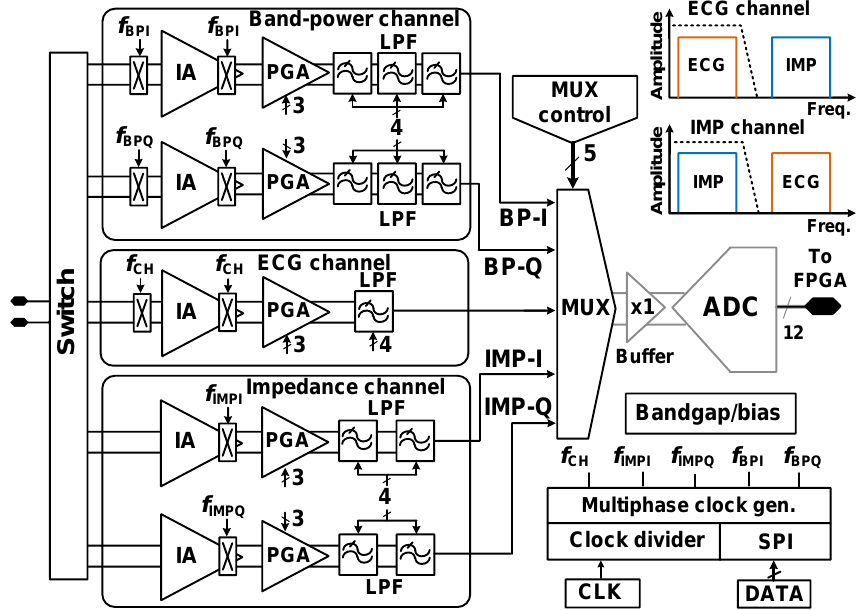
Figure 12. Block diagram of the back-end signal processing IC. The spectrums of the ECG and IMP channels are shown in the inset.